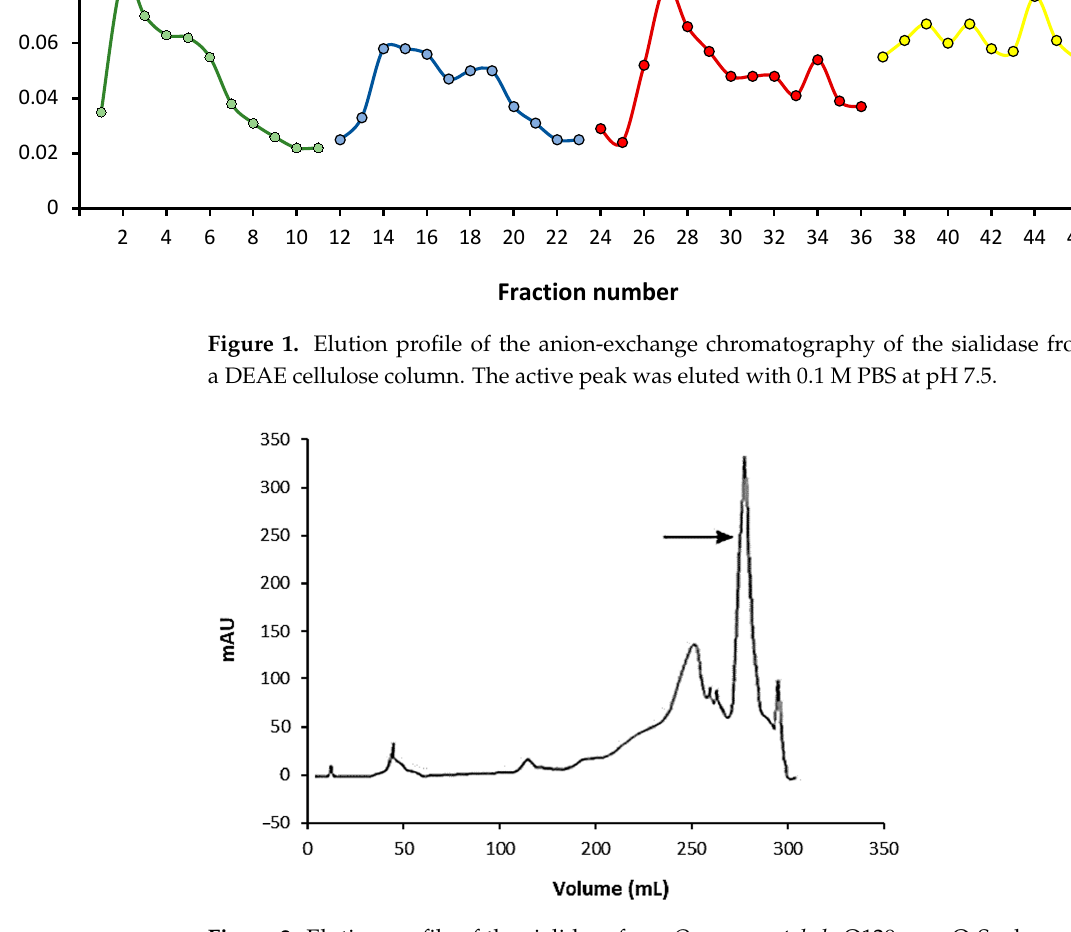
Figure 2. Elution profile of the sialidase from O. paurometabola O129 on a Q-Sepharose column in an FPLC system. The active peak is indicated by the arrow.